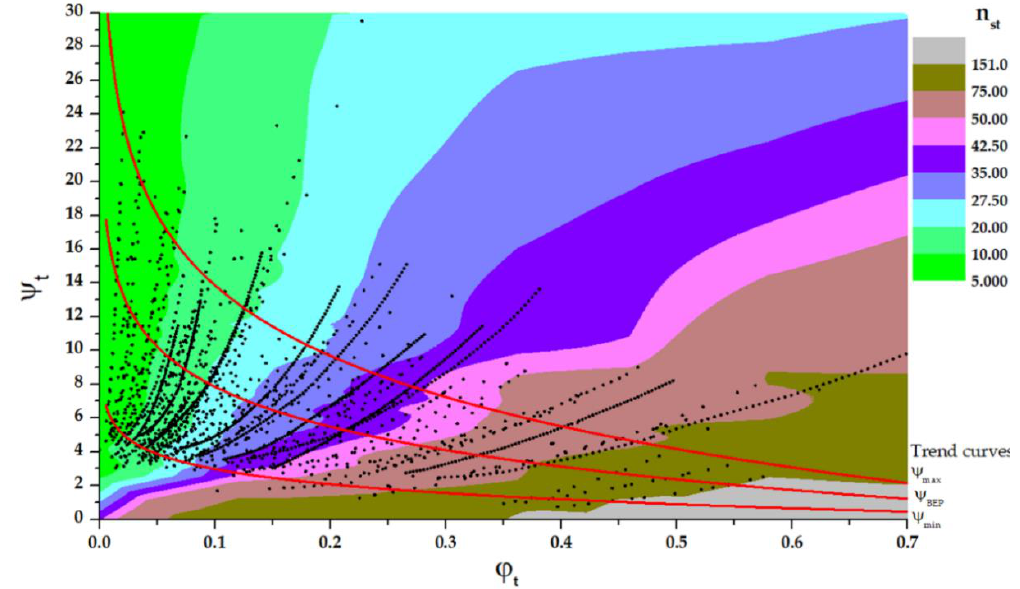
Figure 5. Experimental curves as a function of 𝑛 𝑠𝑡 .